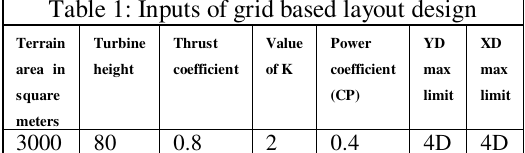
Table 1: Inputs of grid based layout design Terrain